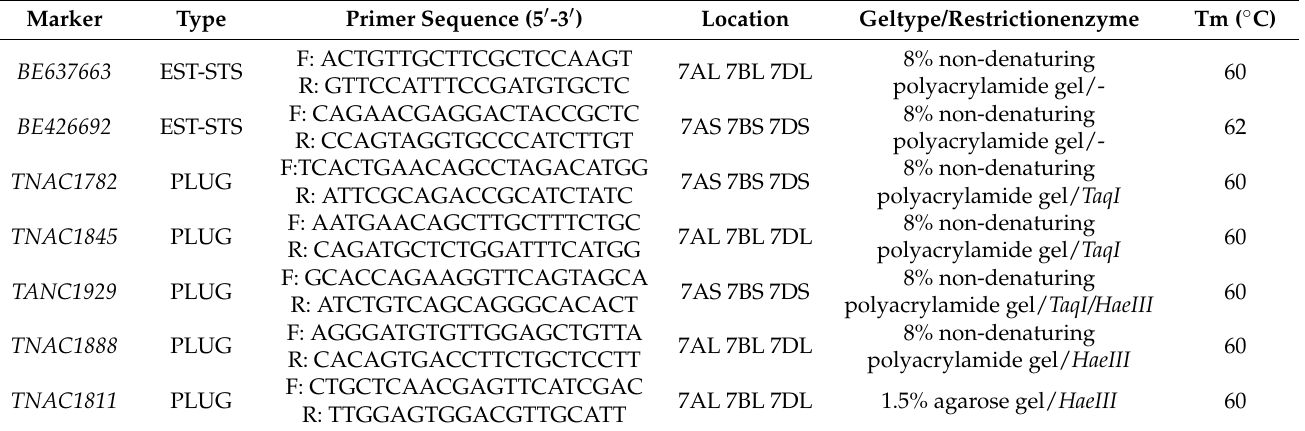
Table 1. EST-STS and PLUG markers used in this study of W623 and W637.